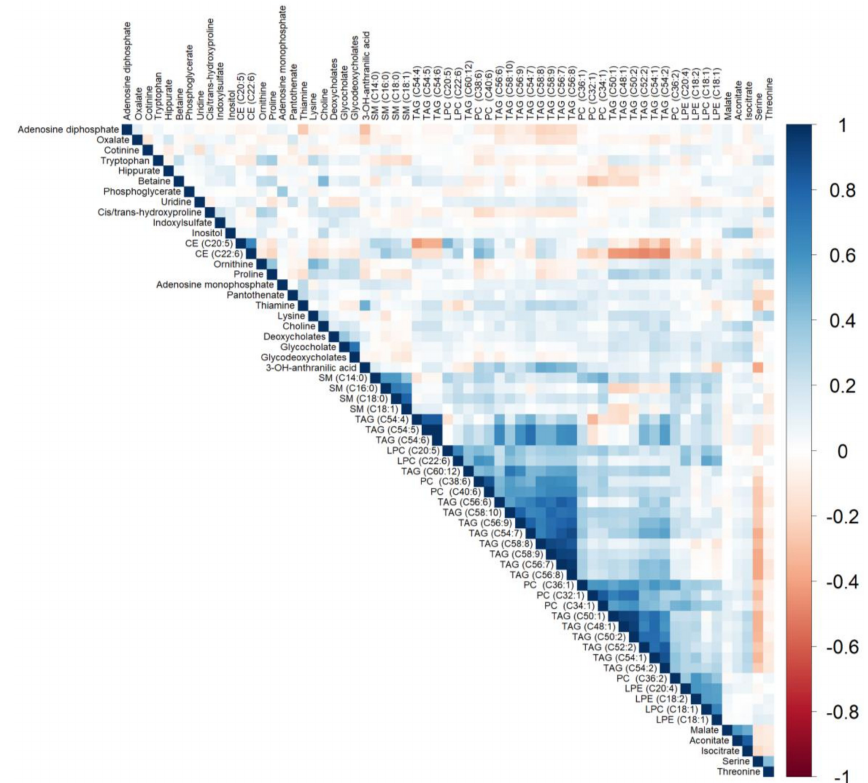
Figure 4. Heatmap depicting Spearman’s partial correlation coe ffi cients adjusted for age and sex between metabolites that were statistically significant (FDR p ≤ 0.05) in multivariable models adjusting for age, sex, total caloric intake, current smoking, physical activity index, lipid lowering medication, anti-hypertensive medication, and body mass index. CE, cholesterol ester; FDR, false discovery rate; LPC, lysophosphatidylcholine; LPE, lysophosphatidylethanolamine; PC, phosphatidylcholine; SM, sphingomyelin; TAG,